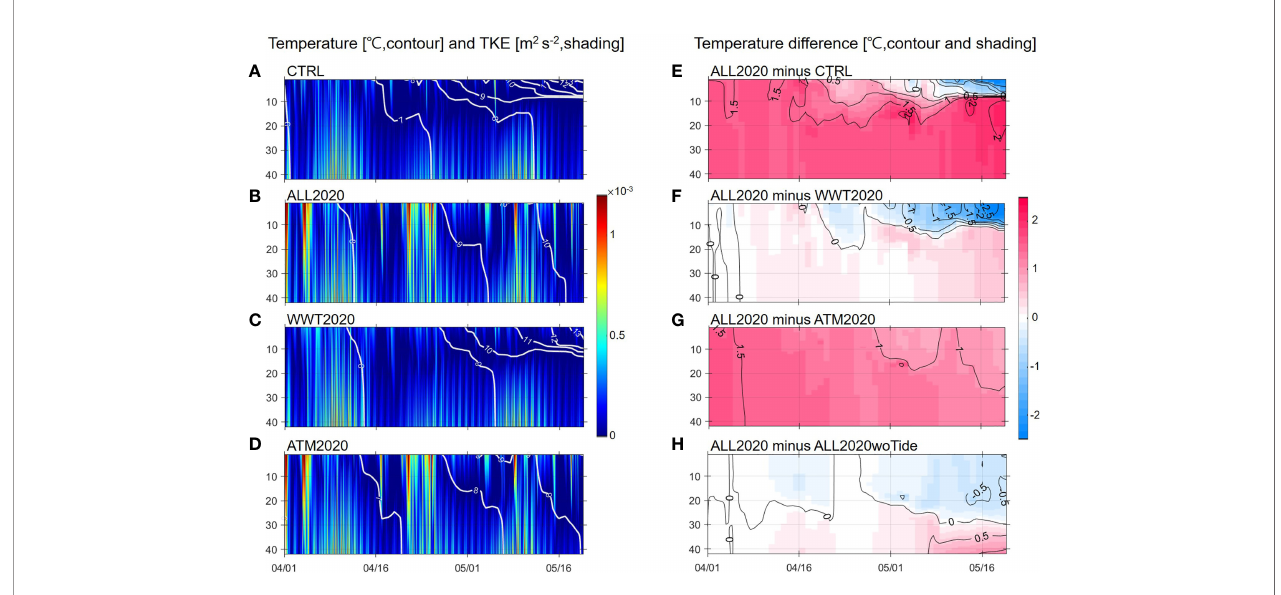
FIGURE 4 | Time-depth diagram of temperature (°C, contour) and turbulent kinetic energy (m 2 s -2 , shading) simulated by the (A) CTRL, (B) ALL2020, (C) WWT2020, and (D) ATM2020 experiments for the period 1 April – 20 May. Impact of (E) all factors (atmospheric forcing+initial water temperature+tidal forcing), (F) atmospheric forcing, (G) initial water temperature, and (H) tidal forcing on the spring temperature evolution, which was estimated by the temperature differences between the ALL2020 and CTRL, the ALL and WWT2020, the ALL2020 and ATM2020, and the ALL2020 and ALL2020woTide,